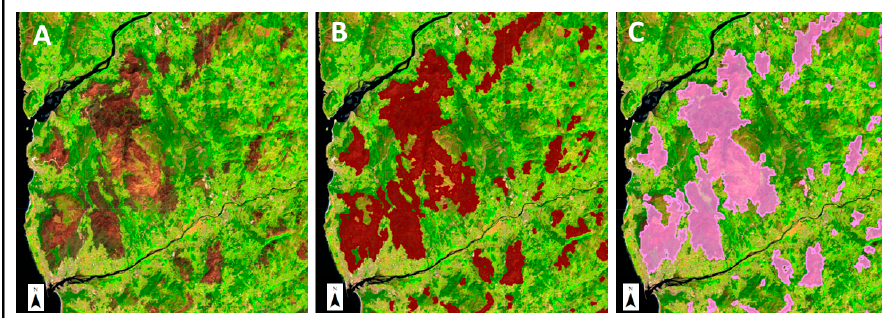
Figure 11. ( A ) Landsat RGB 542 image, path/row: 204/031, date 18 September 2005; ( B ) in red: burnt area classification; ( C ) in pink: the ICNF burnt area classification.